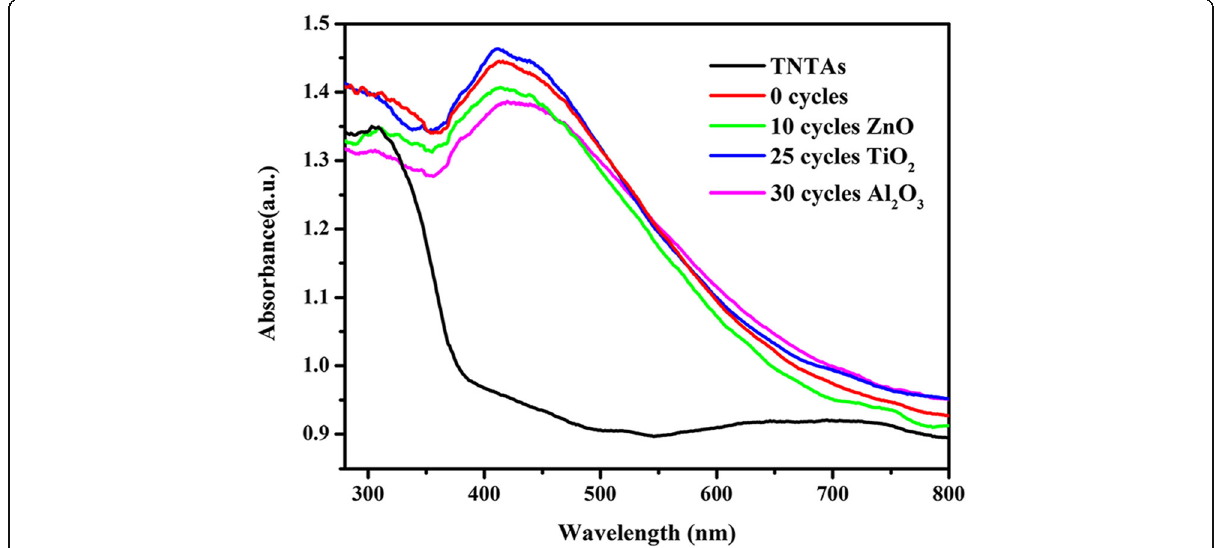
Fig. 5 UV-vis absorption spectra of the pure TNTAs, TNTAs/QDs, TNTAs/QDs/10 cycles ZnO, TNTAs/QDs/25 cycles TiO 2 , and TNTAs/QDs/30 cycles Al 2 O 3 electrodes